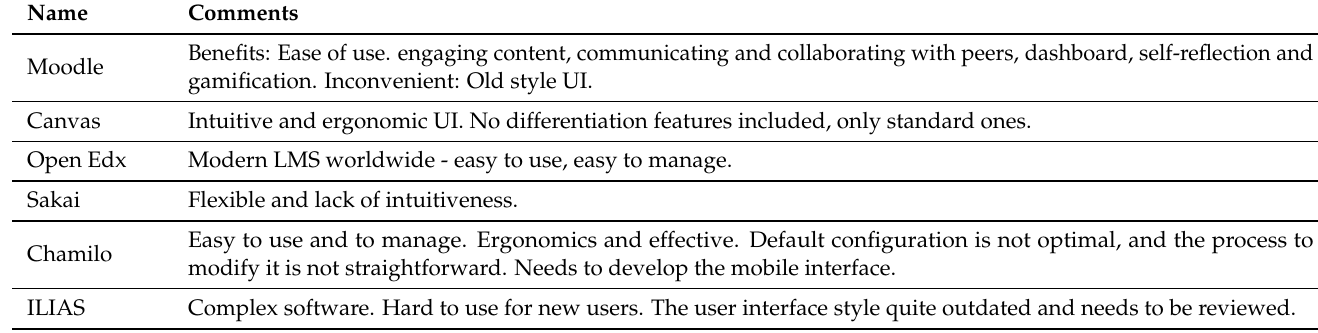
Table 3. Shortlisted